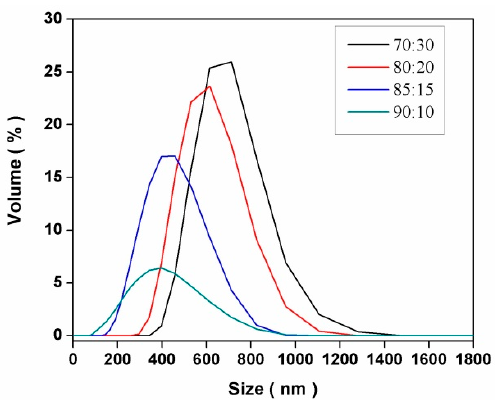
Figure 4. The influence of continuous: dispersed phase ratios of 70%:30%, 80%:20%, 85%:15%, and 90%:10% on the PU NCs size.